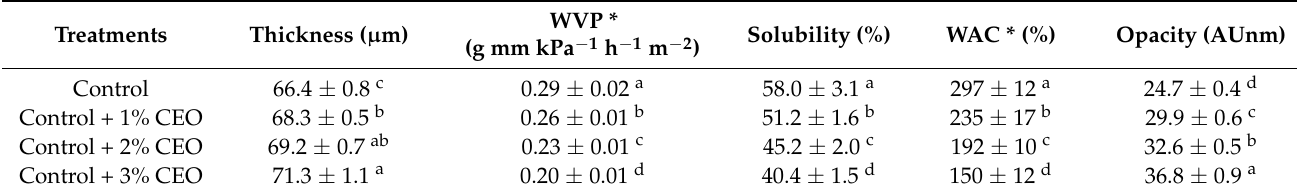
WVP * Solubility (%) WAC * (%) Opacity (AUnm) (g mm kPa − 1 h − 1 m − 2 )